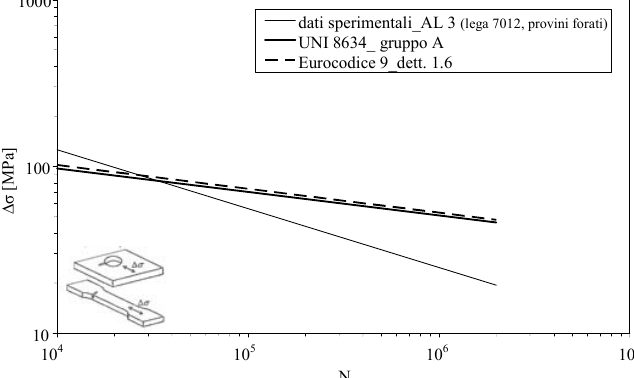
Figura 7: Confronto tra curva di resistenza a fatica per materiale base in lega 7012 (provini